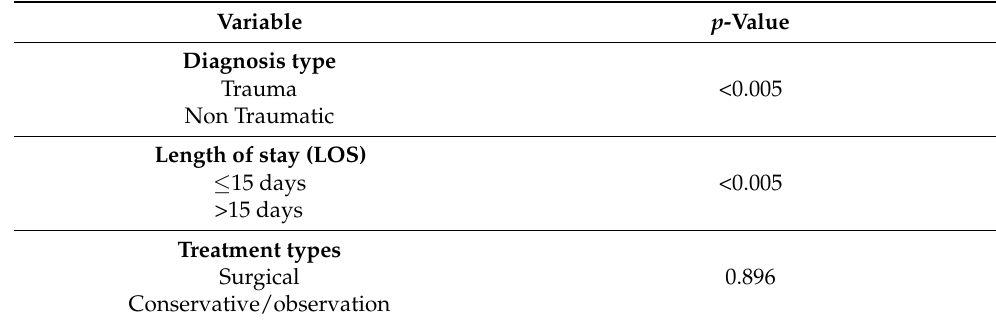
Table 4. The association between the GCS on arrival and other